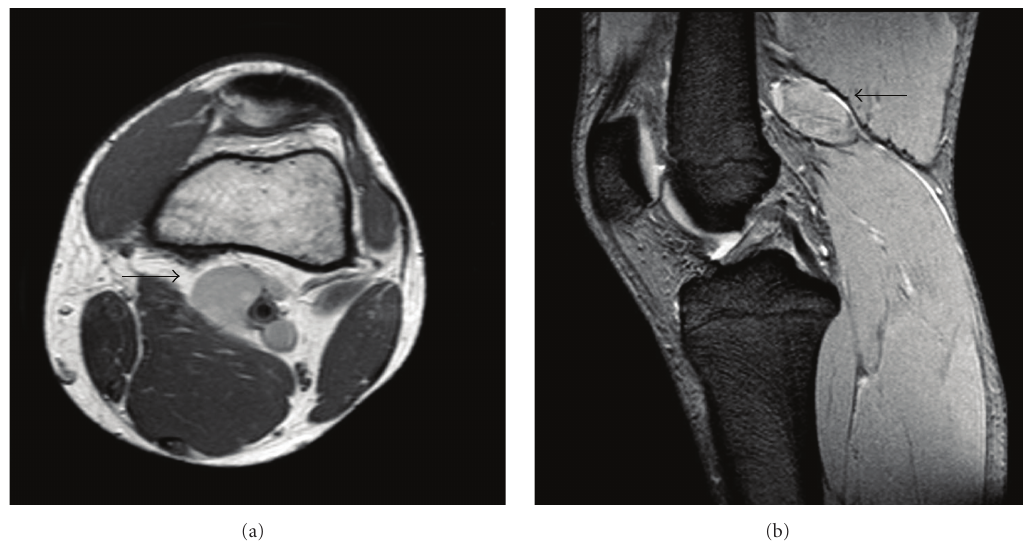
Figure 1: Magnetic Resonance (MRI), SE T1 Dual axial (a), SE T2 FFE sagittal (b) showing a 4 cm oval-shaped formation with dishomogeneous hyperintensity in the left popliteal fossa adjacent to the